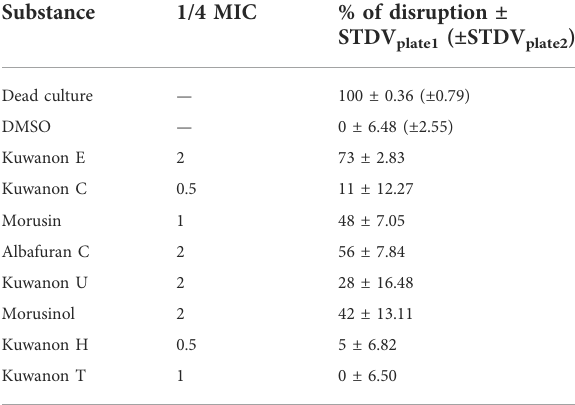
TABLE 4 Membrane disruption (%) of MRSA 7109 caused by natural compounds at 1/4 of the MIC.